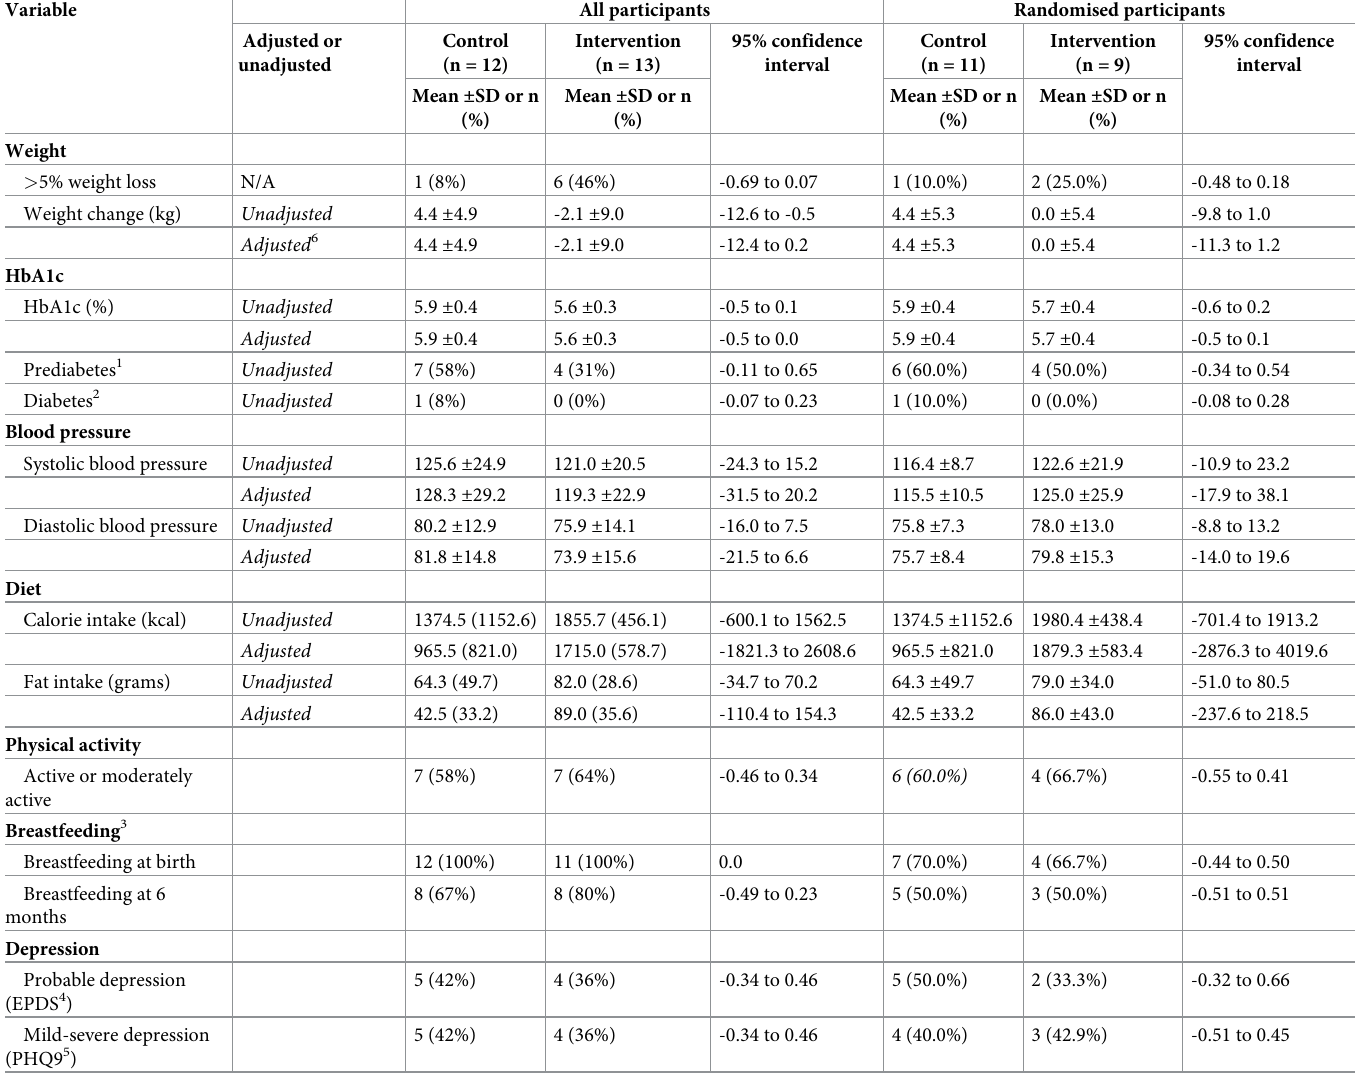
Table 6. Clinical outcomes at follow up (6 months postpartum) by on-treatment analysis using one way ANCOVA: All participants and randomised participants. Variable All